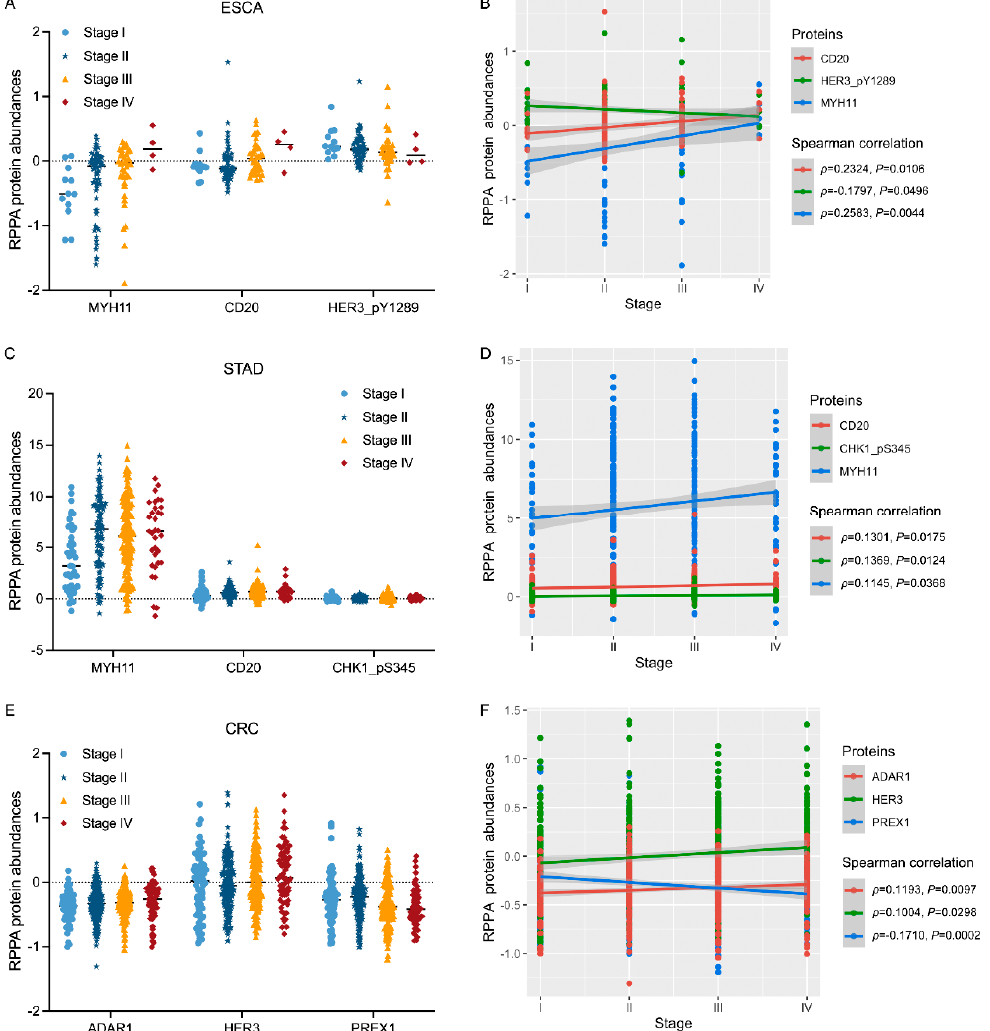
Figure 4. Associations of protein biomarkers with tumour stage: ( A ) scatter plot of proteins MYH11 , CD20, and HER_pY1289 in stages I/II/III/IV of ESCA tumours; ( B ) Spearman correlation analysis of proteins MYH11 , CD20 , and HER_pY1289 with tumour stage in ESCA; ( C ) scatter plot of proteins MYH11 , CD20 , and CHK1_pS345 in stages I/II/III/IV of STAD tumours; ( D ) Spearman correlation analysis of proteins MYH11 , CD20 , and CHK1_pS345 with tumour stage in STAD; ( E ) sca tt er plot of proteins ADAR1 , HER3 , and PREX1 in stages I/II/III/IV of CRC tumours; ( F ) Spearman correlation analysis of proteins ADAR1 , HER3 , and PREX1 with tumour stage in CRC. The survival analysis for identifying risk clinical parameters of tumour patients was conducted using the Cox proportional hazard model. In univariate Cox regression analy- sis, tumour stage was identi fi ed as a signi fi cant risk factor for poor overall survival in ESCA [hazard ratio (HR) = 2.2683, p < 0.05], STAD (HR = 1.5882, p < 0.01), and CRC (HR = 1.0242, p < 0.05) patients. In addition, higher age was associated with more prognostic risk in STAD (HR = 1.0296, p < 0.05) and CRC (HR = 1.0273, p < 0.05) patients, while lower BMI indicated be tt er prognosis in CRC patients (HR = 0.9351, p < 0.05). Overall, other clinical parameters, including sex, race, and tumour neoplasm histologic grade, had no signi fi cant e ff ects on overall survival in ESCA, STAD, and CRC patients ( p > 0.05 in Cox regression) in our analysis, as shown in Figure 5.